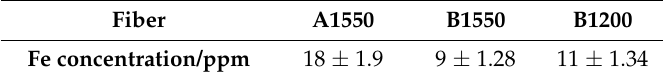
Table 4. Fe concentrations in the fibers derived from the sol-gel based granulated silica